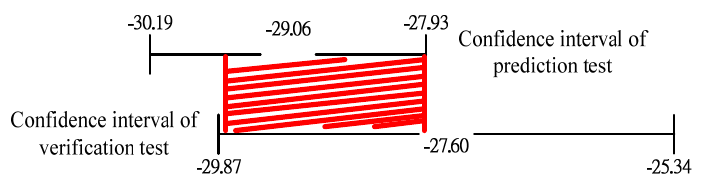
Figure 7. Relation between confidence intervals of predicted value and actual value.